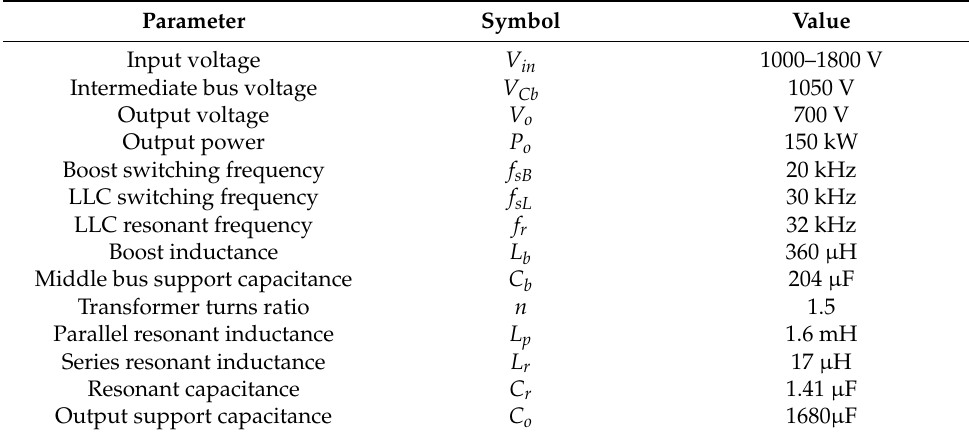
Table 1. Standard circuit parameters of the ISOP